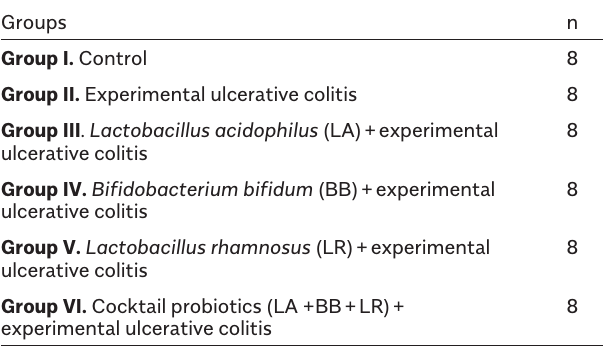
Groups n Group I.